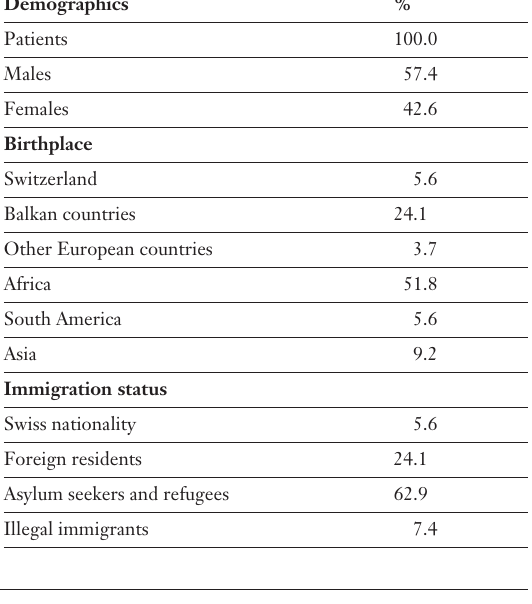
Figure 1 Age distribution of patients treated under DOT, by gender.